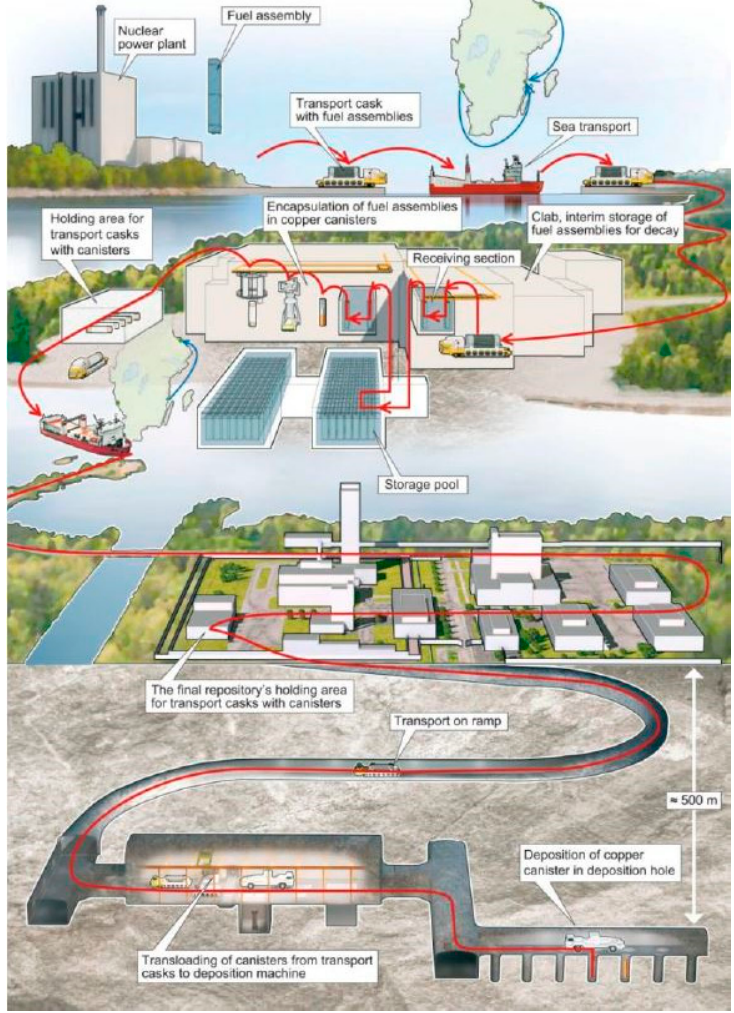
Figure 2. Spent nuclear fuel path along facilities. Source: SKB.